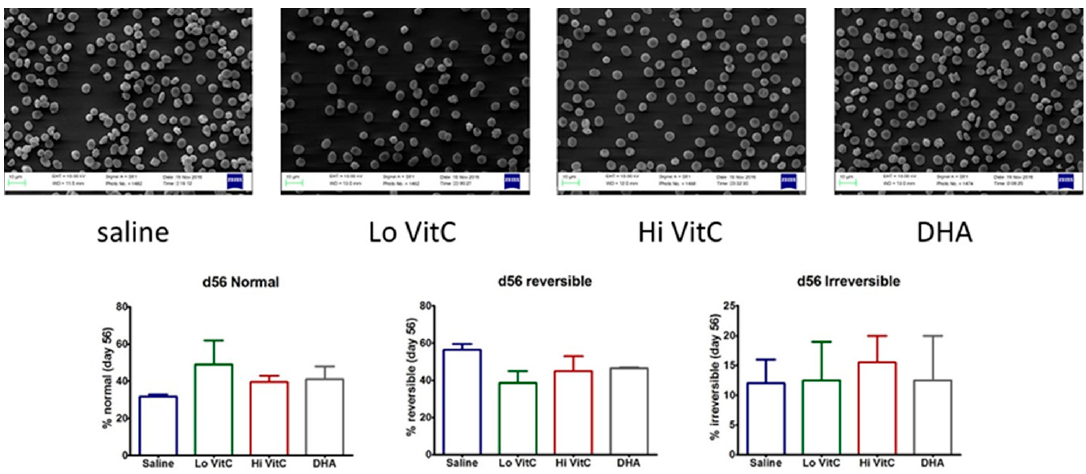
Figure 7. Expression of β -spectrin in stored RBC. The β -spectrin content of RBC stored in saline progressively declined over 56 days. Addition of reduced VitC (Lo/Hi) or oxidized VitC (DHA) increased β -spectrin levels of RBC over saline (Sa). However, these changes did not reach statistical significance. ( N = 5/group, p > 0.05).).